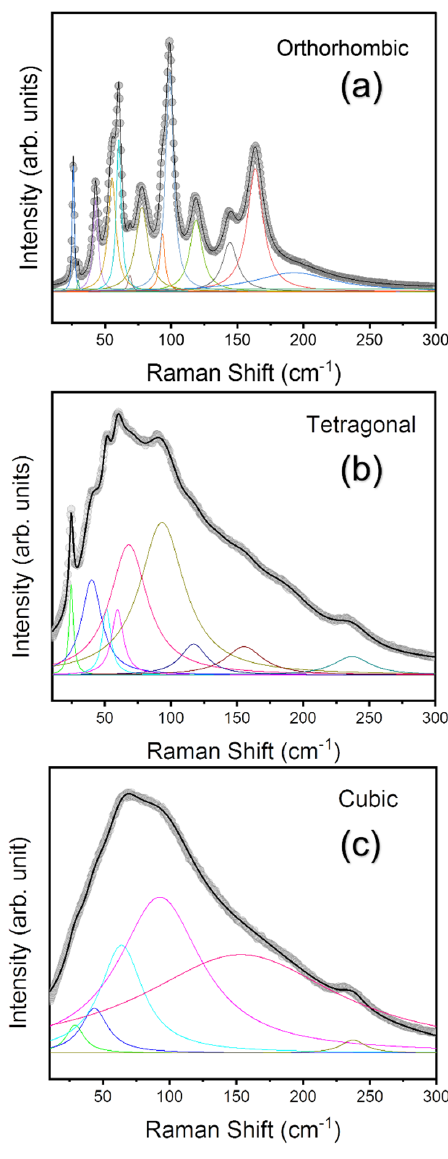
Figure 5. (Color online) Raman spectra and best-fitted curves of MAPbCl 3 single crystal in the orthorhombic ( a ), tetragonal ( b ), and cubic phases ( c ). The grey circles and black solid line indicate raw and overall fitted spectrum, respectively. The colored solid lines represent fitting curves of individual Raman modes.